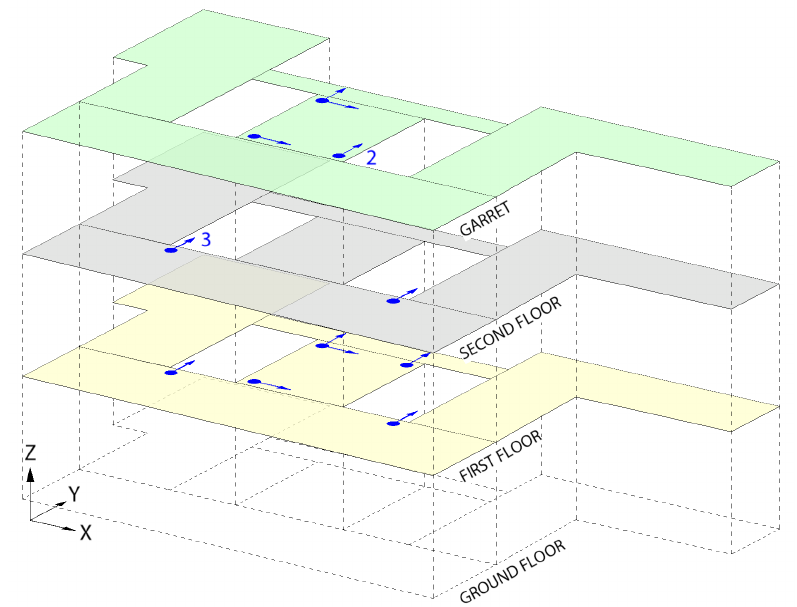
Figure 5. Position and direction of the